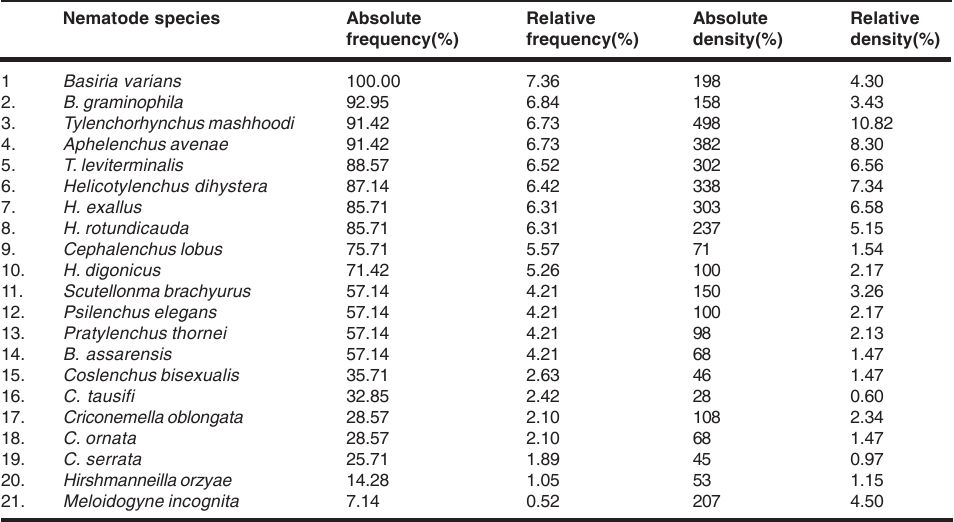
Table 1. Nematode species identified with their absolute frequency, relative frequency, absolute density and relative density. Nematode species Absolute Relative Absolute Relative frequency(%) frequency(%) density(%)